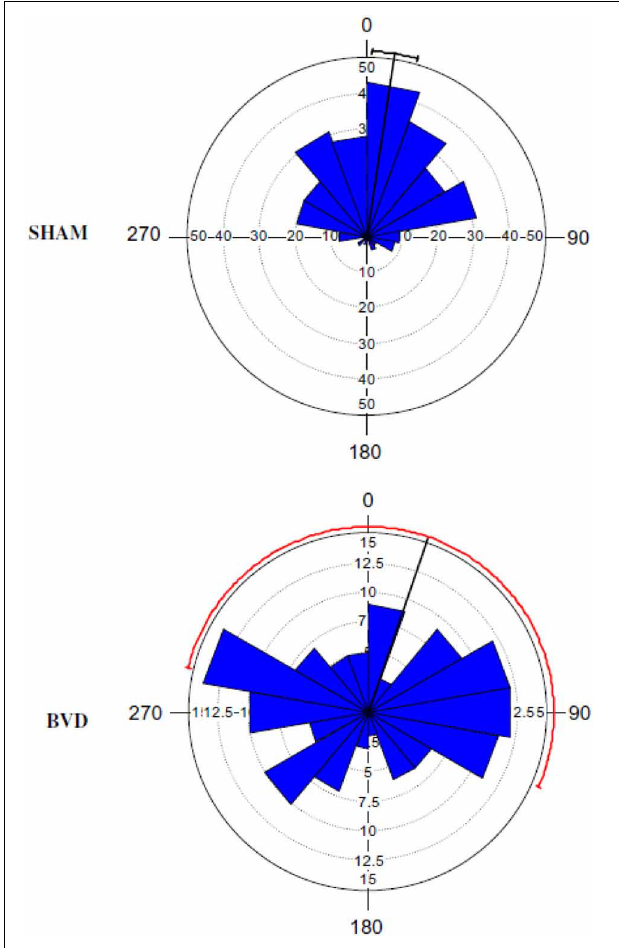
FIGURE 1 | A Rose diagram indicating the initial heading angles of SHAM and BVD rats at 14 months post-op. in a foraging task in darkness, in which they had to remember their way to a home base. The mean vector is indicated by the black line and the 95% confidence interval (CI) for the mean is indicated by the line extending either side. The 95% CIs for the BVD animals were unreliable due to the low concentration of vectors. The inner circles (dotted line) indicate the number of observations for the given vectors (blue triangles). Reproduced with permission from Baek et al.